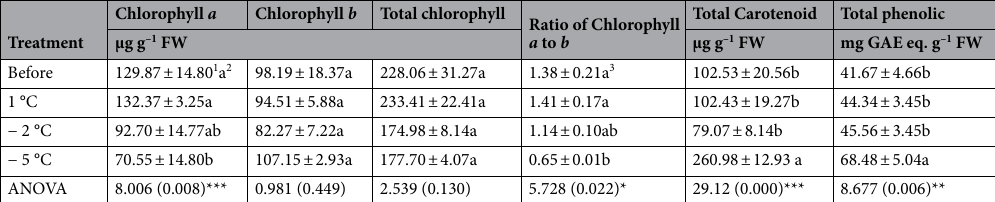
Table 1. Changes in chlorophyll, carotenoid, and phenolic contents of three-year-old ‘Hass’ avocado seedling leaves before treatment and 24 h after treated with 1, − 2, and − 5 °C for 1 h. 1 Means with standard errors from three replicates with five leaf each. 2 Means within columns followed by different lowercase letters are significantly different according to Tukey’s honestly significant difference test at p < 0.05. 3 Statistical